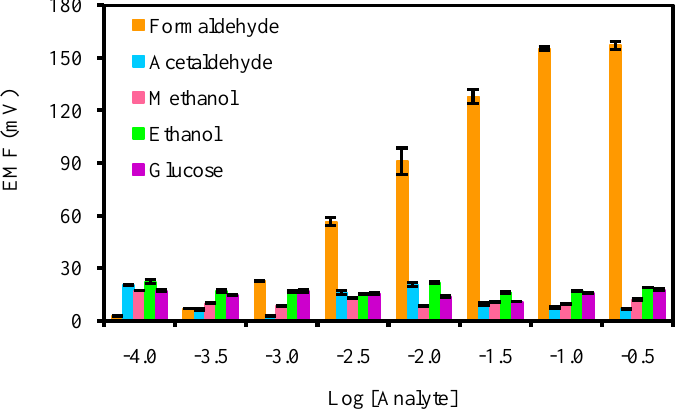
Figure 6. Effects of interfering substances on the response of biosensor based on AOX- poly(nBA-NAS) microspheres in 10 mM Tris-HCl buffer (pH 6.5) as background